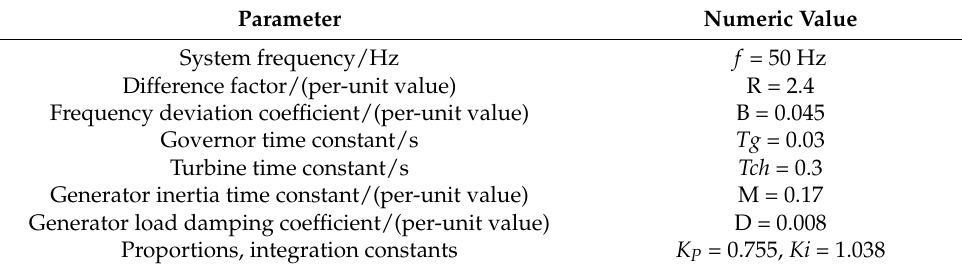
Table 1. Basic experimental parameters of the model.